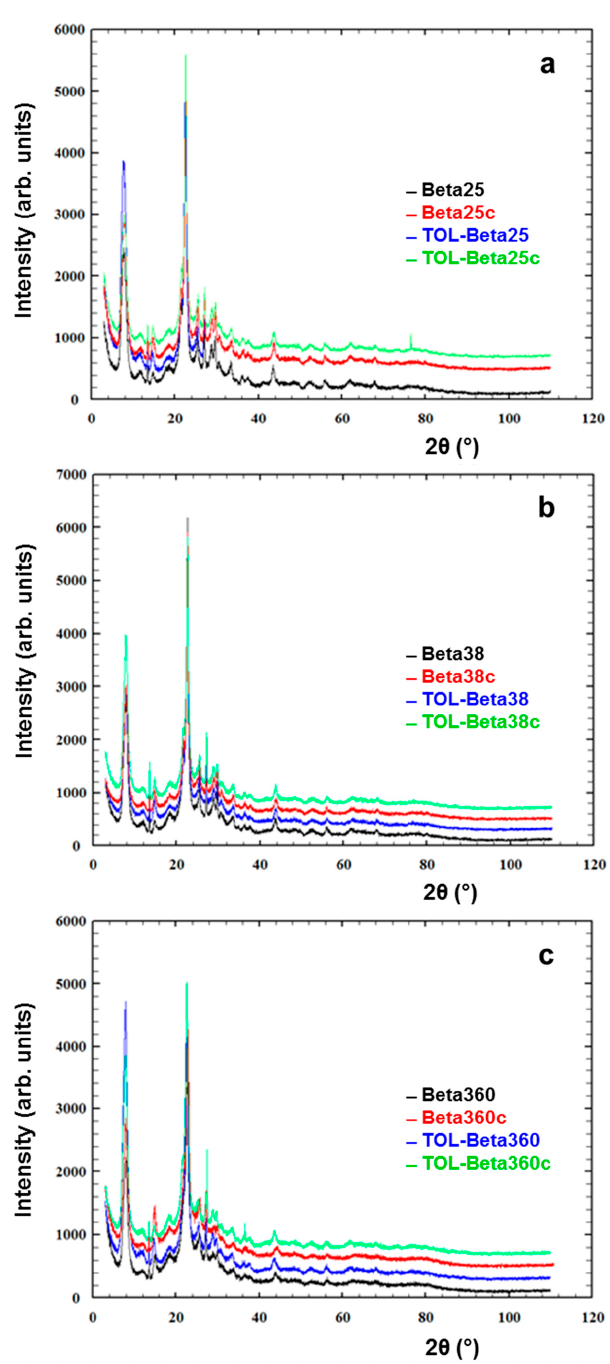
Figure 3. Thermogravimetric curves of as-received and calcined BEAs, before and after saturation with TOL: ( a ) Beta25; ( b ) Beta38; and ( c ) Beta360.